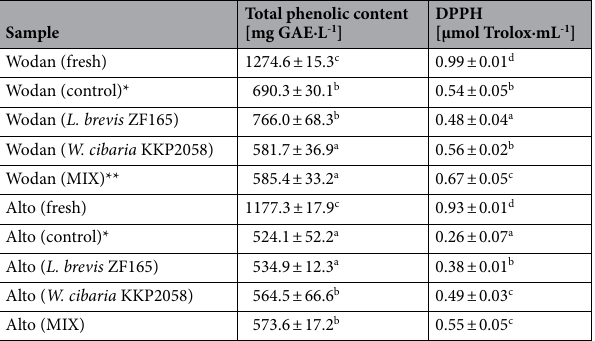
Table 5. The total phenolic content and antioxidant activity of juices obtained during spontaneously and inoculated fermented red beet juice. *Control: spontaneous fermentation. **MIX: L. brevis ZF165; W.